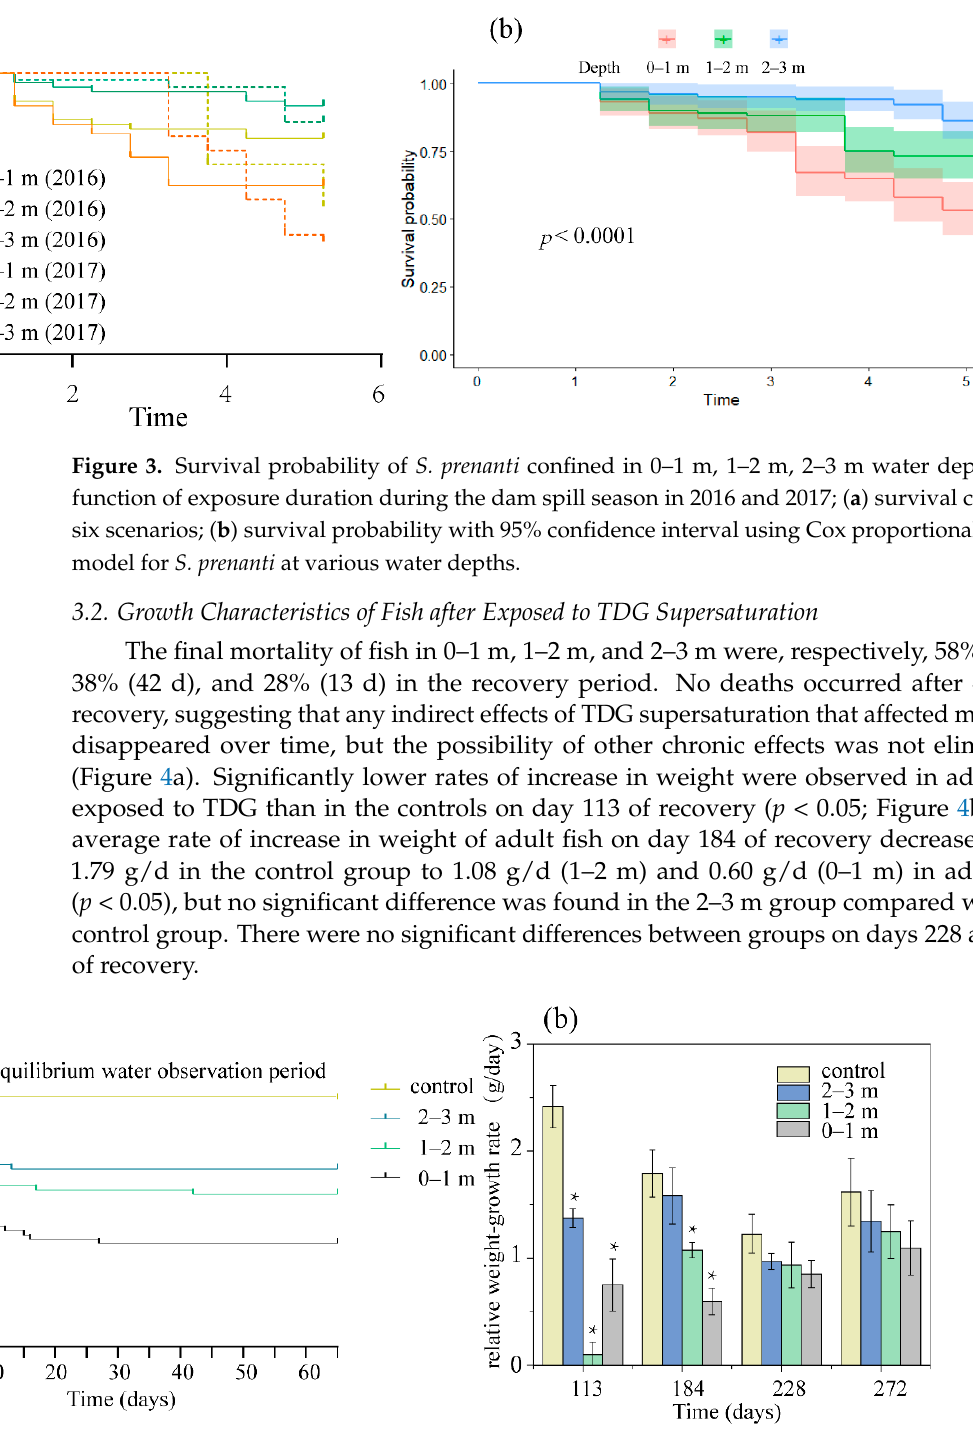
Figure 4. TDG-induced effects on fish survival and growth: ( a ) survival curves of adult S. prenanti for the initial period of TDG supersaturated exposure (6 d) and subsequent equilibrated water observation (59 d), with the control group in the equilibrated water for the entire observation period (65 d); ( b ) changes in the relative weight growth rate of S. prenanti in equilibrated water after 113 d, 184 d, 228 d, and 272 d of recovery, with the average weight of fish from the treatment group and the control group at 65 d considered to be the initial weight. Asterisks indicate significance for p < 0.05 .